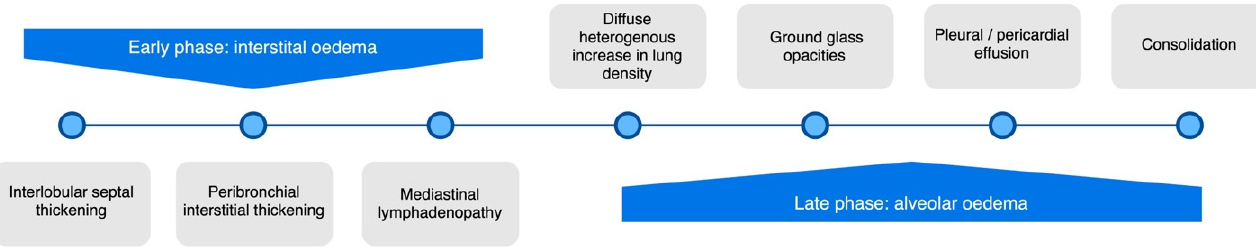
Figure 10. ( left ) Pulmonary findings related to HF in CT. A: Bilateral pleural effusion; B: Ground- glass opacities in gravity-dependent part of the lungs; C: Smooth septal thickening. ( right ) Image of the lungs in HF. A: Bilateral pleural effusion; B: interlobar septal thickening; C: Thickening of